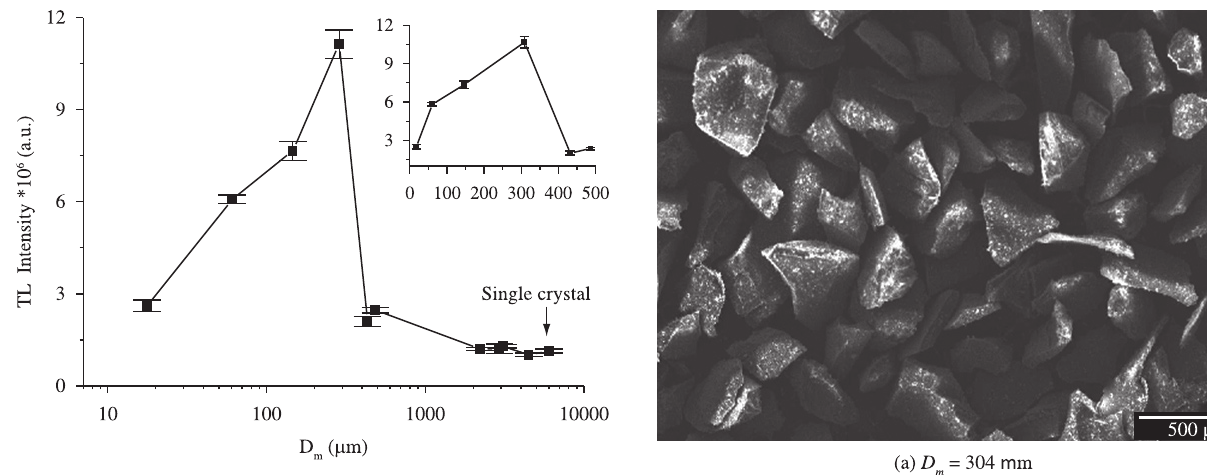
Figure 4. Relationship between TL intensity integrated from 175 to 390 °C and the mean particle size ( D ) for sensitized quartz (test dose: 50 mGy). The m inset plot corresponds to the initial part of the figure in a linear scale.